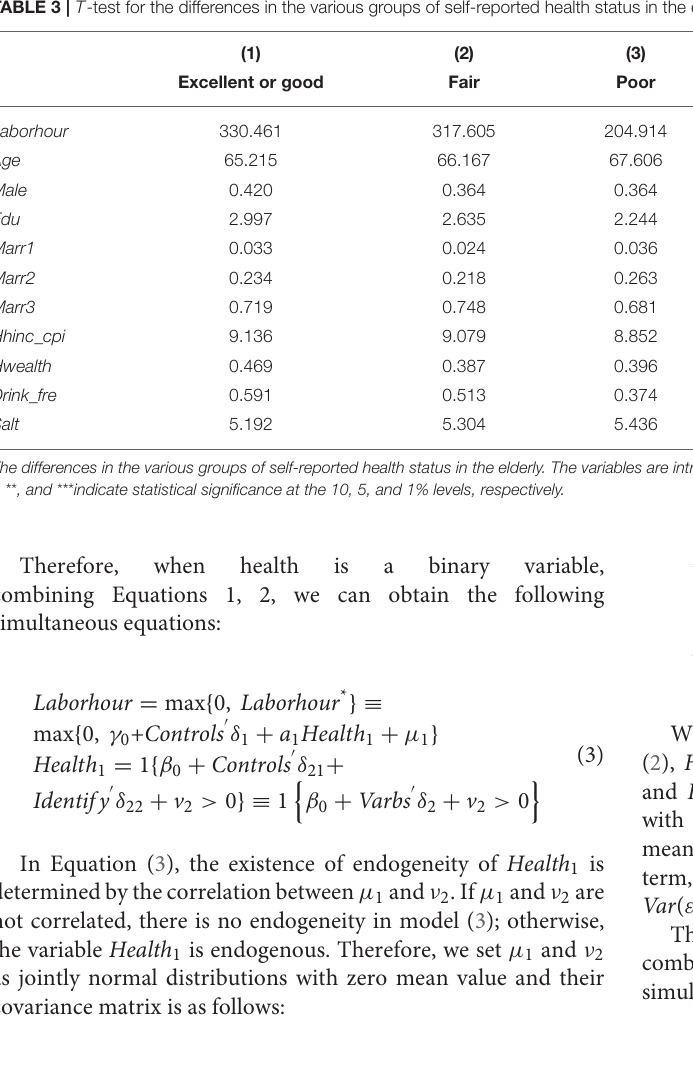
TABLE 3 | T -test for the differences in the various groups of self-reported health status in the